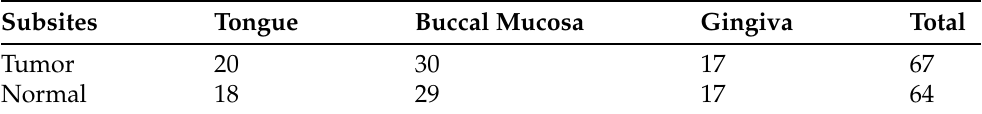
Table 1. Illustration of tested tissue